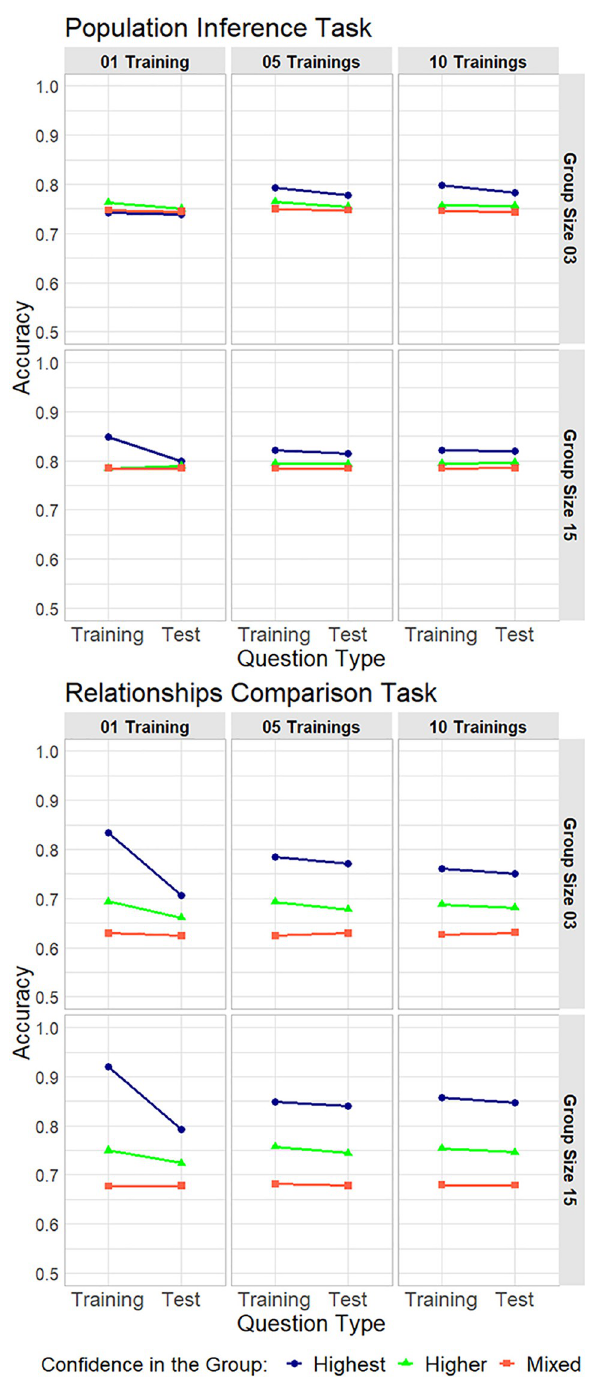
Fig 7. Accuracy differences between training and test questions obtained from computer simulations of group judgments. The Upper 6 and lower 6 panels show the results in a population inference and relationships comparison task, respectively. In the computer simulations, we calculated the mean accuracy of 5,000 iterations (regarded as an index of group performance). In each task, two rows correspond to two conditions of group size (3 or 15), and three columns to three conditions of the number of training questions (1, 5, or 10), respectively. The blue, green, and red lines denote the highest, higher, and mixed confidence groups, respectively.